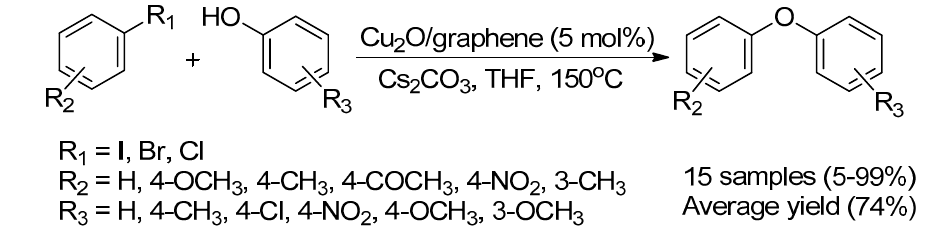
Figure 9. Preparation method of Cu 2 O/graphene.